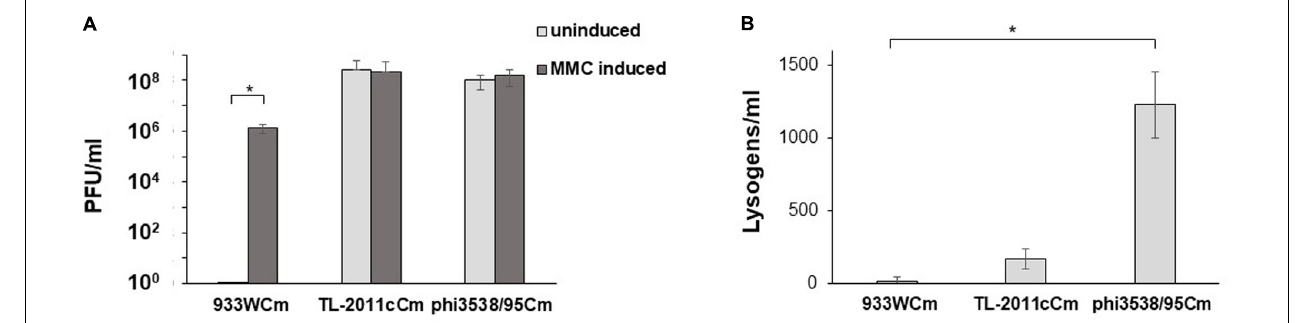
FIGURE 3 | (A) Plaque-forming units (PFU/ml) produced by E. coli C600 carrying either the lambdoid type 933W phage or the Eru1 type phages TL-2011c or Phi3538/95 with and without MMC induction. (B) Lysogens (CFU/ml) at a multiplicity of infection (MOI) of 0.1 in E. coli C600. The assays were performed in four (A) and three (B) independent biological replicates. Error bars represent SD. Asterisks represent statistical differences from pairwise comparisons determined using two-tailed paired Student t tests ( ∗ P <